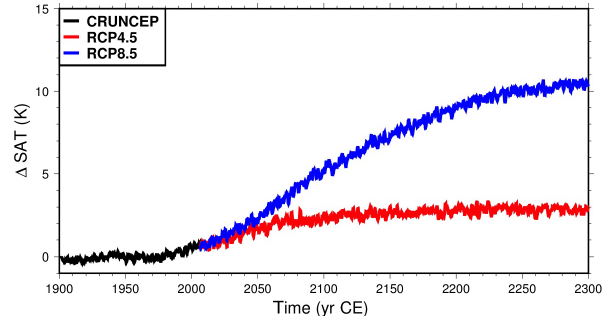
Figure 5. Mean SAT over land relative to the 20th century mean, from the CRUNCEP dataset (black) and the RCP4.5 (red) and RCP8.5 (blue) scenarios. Data are taken from Viovy (2018), Thom- son et al. (2011) and Riahi et al.